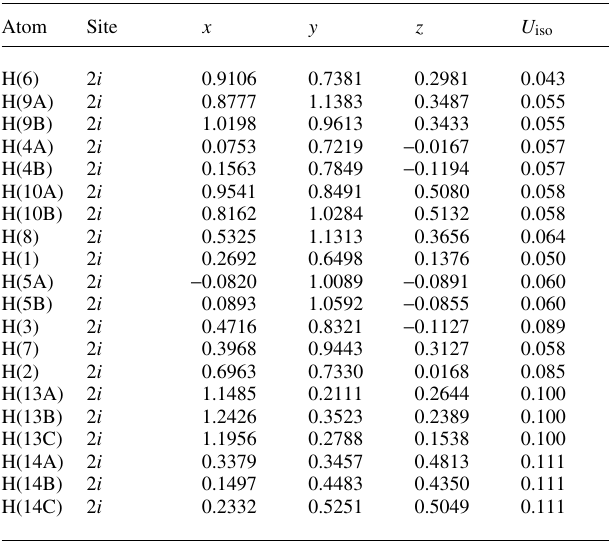
Table 2. Atomic coordinates and displacement parameters (in Å 2 )